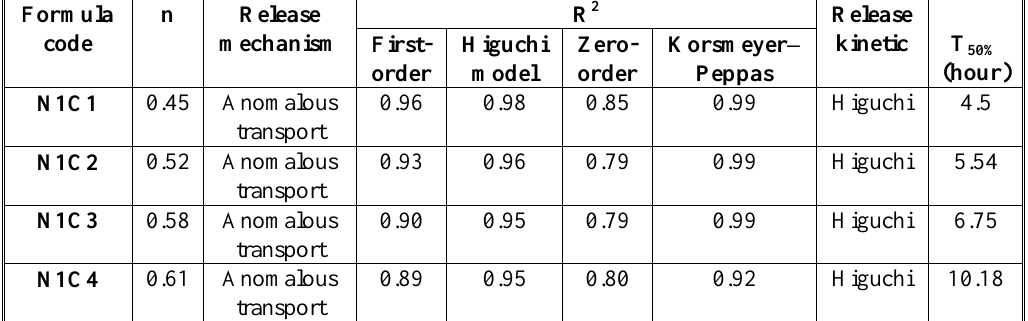
Table (3): Release mechanism and kinetic model of nystatin release from chitosan